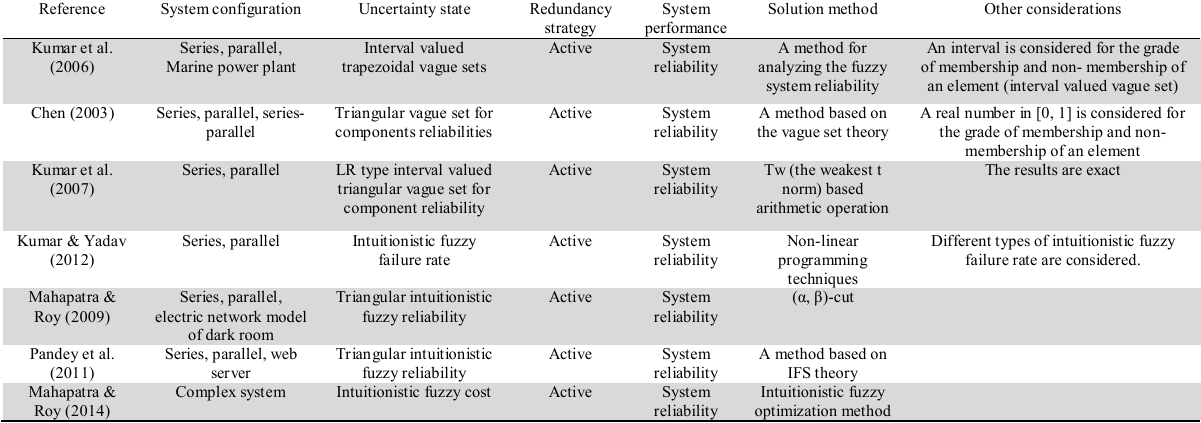
Intuitionistic fuzzy and vague sets Reference